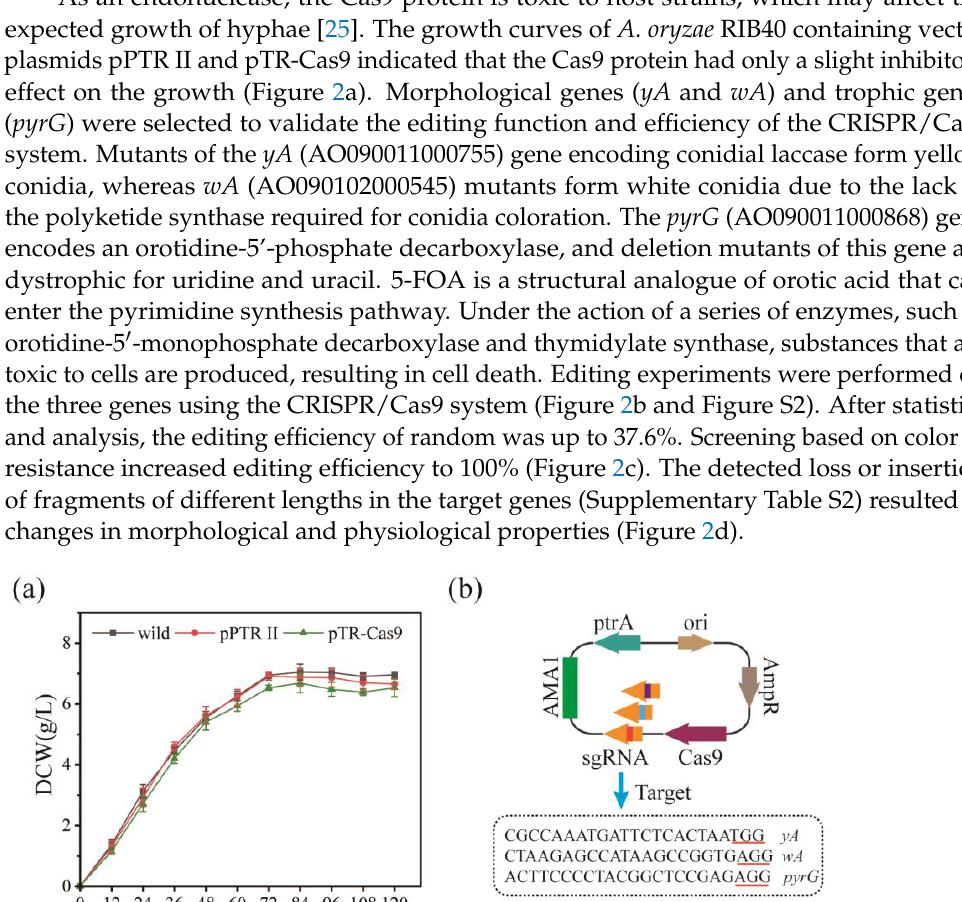
Figure 1. Optimization of conditions for protoplast preparation. ( a ) Comparison of different com- plex enzymes. ( b ) Effect of temperature on protoplast preparation. ( c ) Effect of pH on protoplast preparation. ( d ) Effect of hydrolysis time on protoplast preparation. ( e ) Effect of mycelium amount on protoplast preparation. ( f ) Effect of mycelial culture time on protoplast preparation. ( g ) The effect